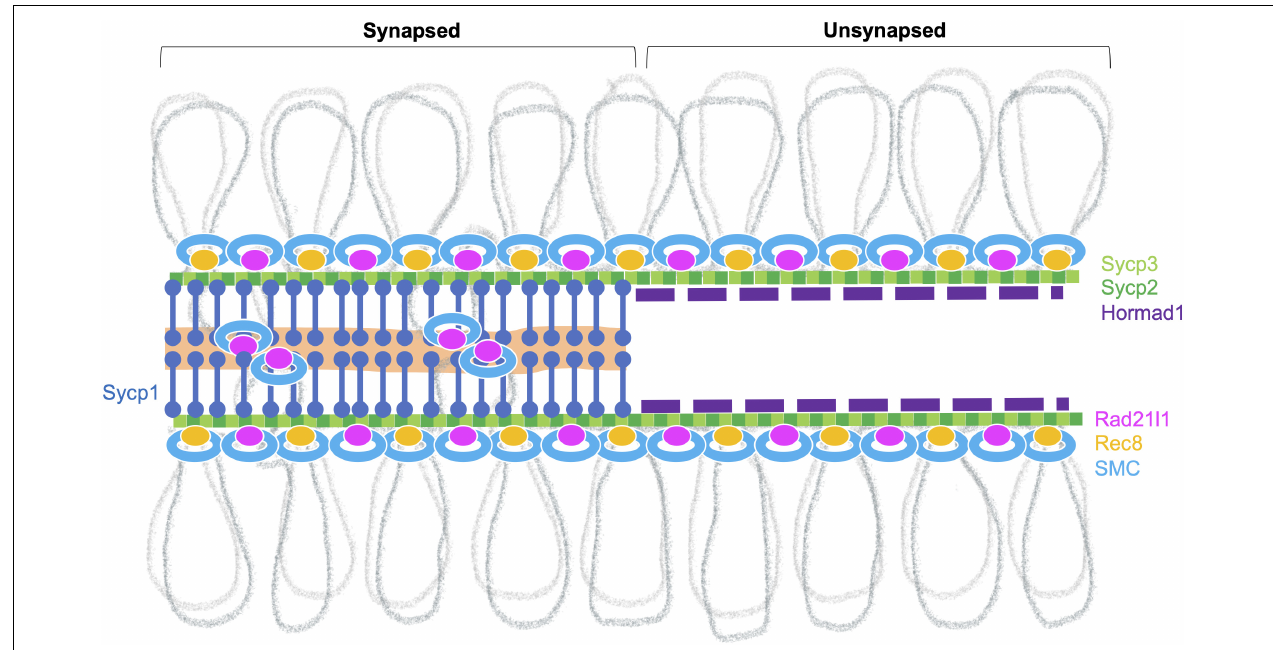
FIGURE 3 | Meiotic chromosome axis structures. The synaptonemal complex comprises the lateral elements (LE, Sycp2 and Sycp3) that run along the lengths of homologous chromosomes joined by a central region that contains the transverse filament (Sycp1) and a central element (a region indicated in orange). Chromosomes joined by this tripartite structure are considered “synapsed.” Prior to synapsis, the LE is referred to as the axial elements (AE) where chromatin is organized into loops that are serially attached to the axis. The chromosome axis is made up of cohesins, the axial element proteins and HORMA-domain proteins. In zebrafish, axis localization has been observed for the cohesin components Smc3, Smc1 β , and Rad21l1, the axial element proteins Sycp2 and Sycp3, and Hormad1. Localization of Rec8a/b (there are two paralogs in zebrafish) and Hormad2 (not shown) remains to be determined. Homologous chromosome pair at the ends as seen by the coalignment of axial elements. While the Rec8 cohesin complex most likely links sister chromatids together, it is not clear what DNA sequences are associated with Rad21l1 complex, however, it could play a role similar to the COH-3/4 cohesin complexes that enable the formation of asymmetric chromosome loops in C. elegans (Wolger et al.,